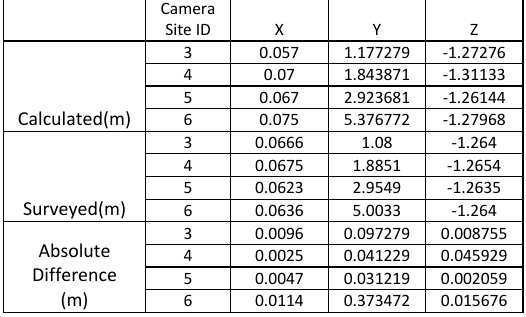
Table 1. System measured results evaluated against total station results